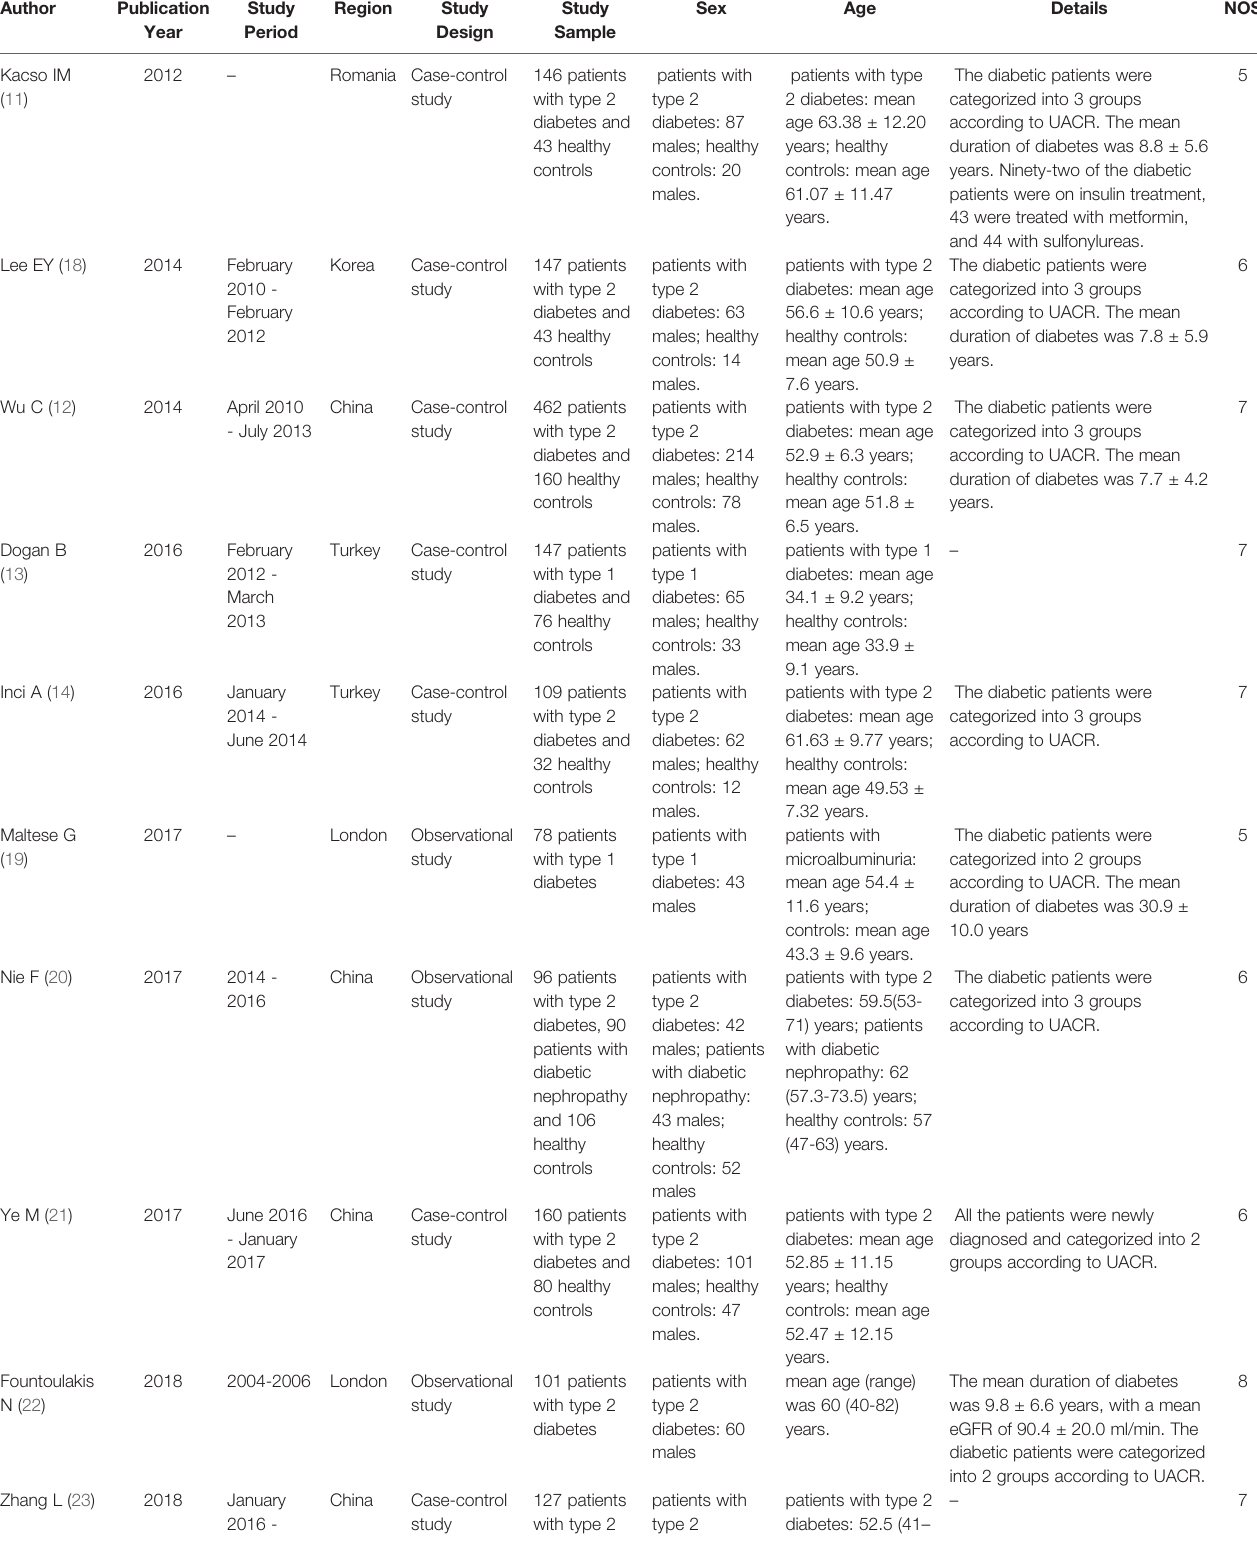
TABLE 1 | Study characteristics of the published studies included in the meta-analysis.